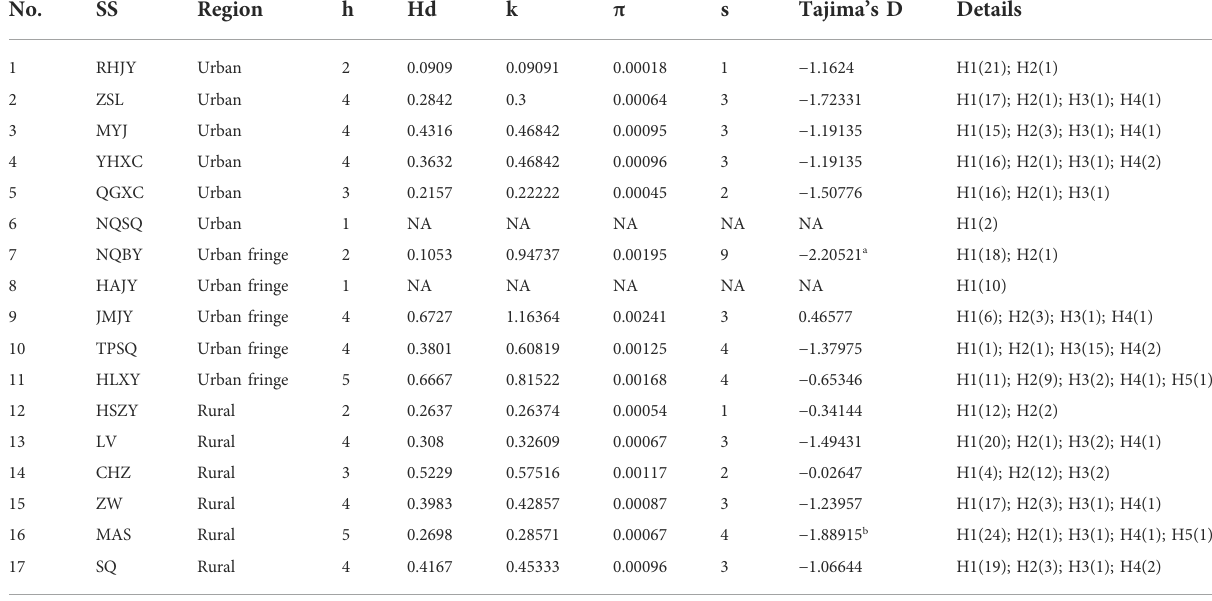
TABLE 5 The genetic diversity indices of all 17 Aedes albopictus populations via Mitochondrial coxI gene. No.